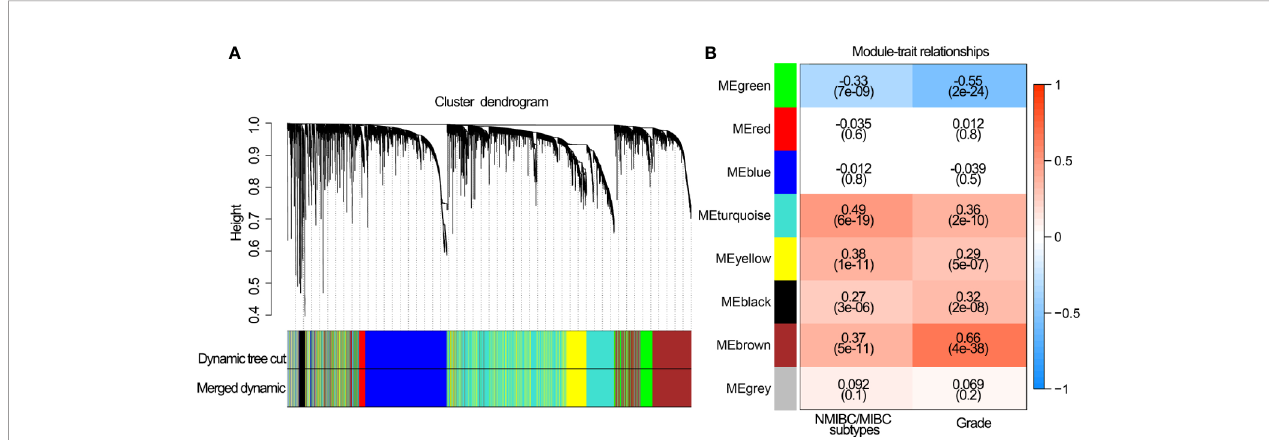
FIGURE 2 | Network construction of the WGCNA and their associations with clinical traits. (A) Clustering dendrogram of 292 samples and associated clinical traits. (B) The scale-free fi t index for various soft-thresholding